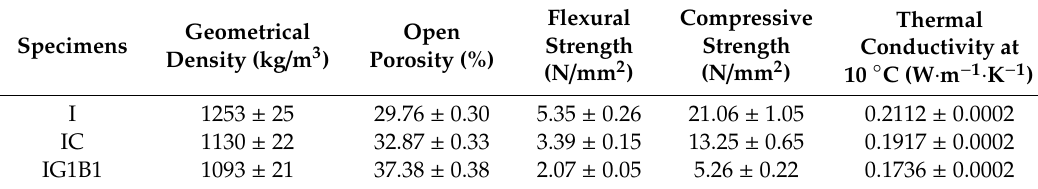
Table 2. Geometrical density, open porosity, flexural and compressive strengths and thermal conductivity of gypsum-based